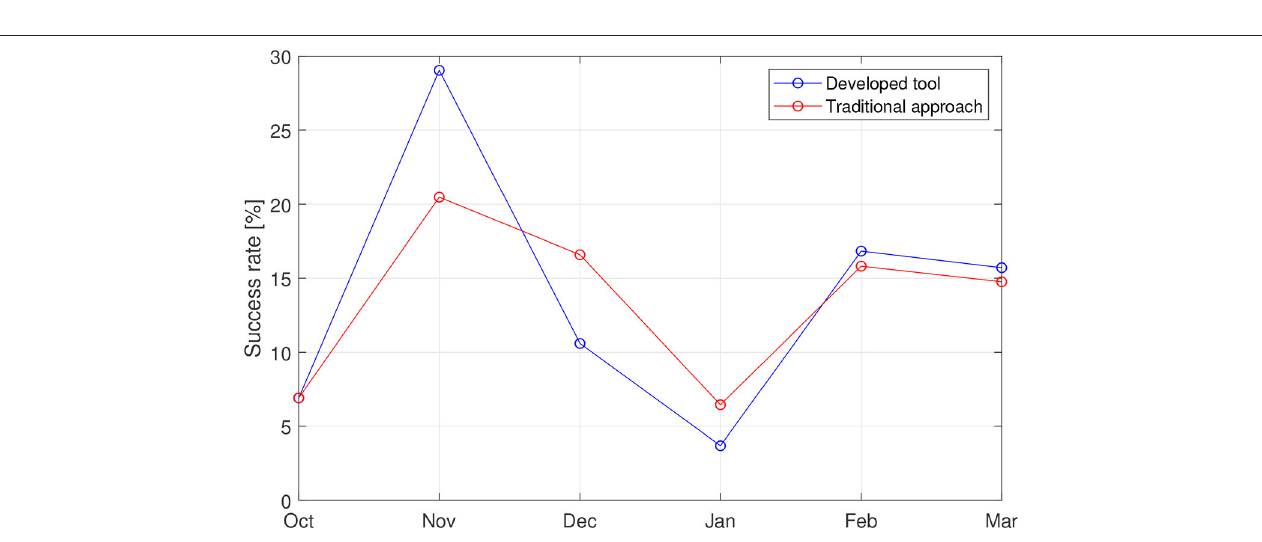
FIGURE 12 | Results of the analysis for the hindcast 1st October 2018–31st March 2019. Monthly success rate over the investigated hindcast period predicted by the developed tool (blue line) and the traditional approach (red